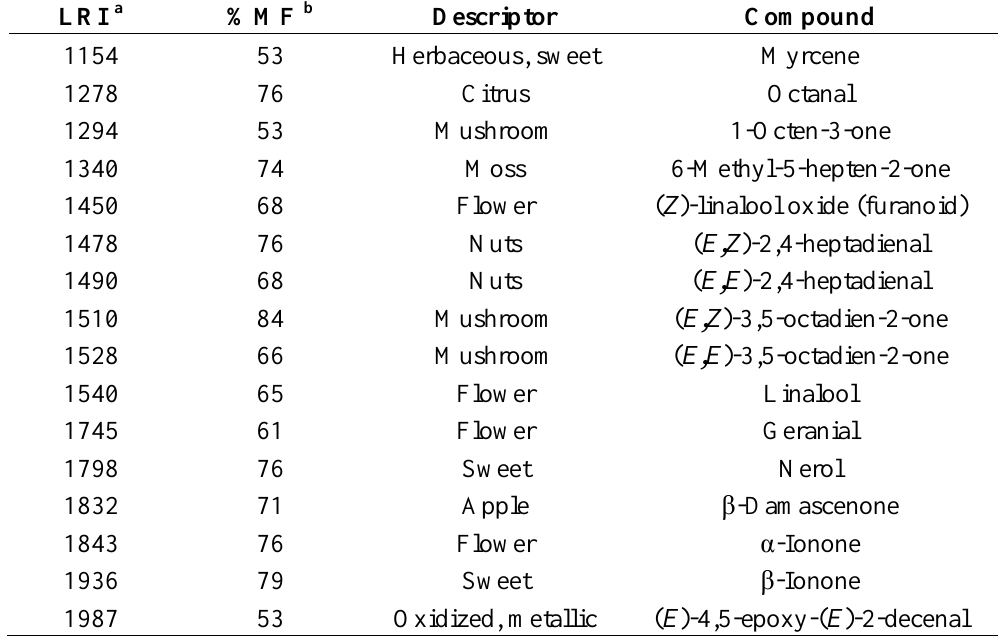
Table 1. Odor-active compounds in yerba mate detected by GC–O with MF ≥ 50 (reprinted from [69] with permission from